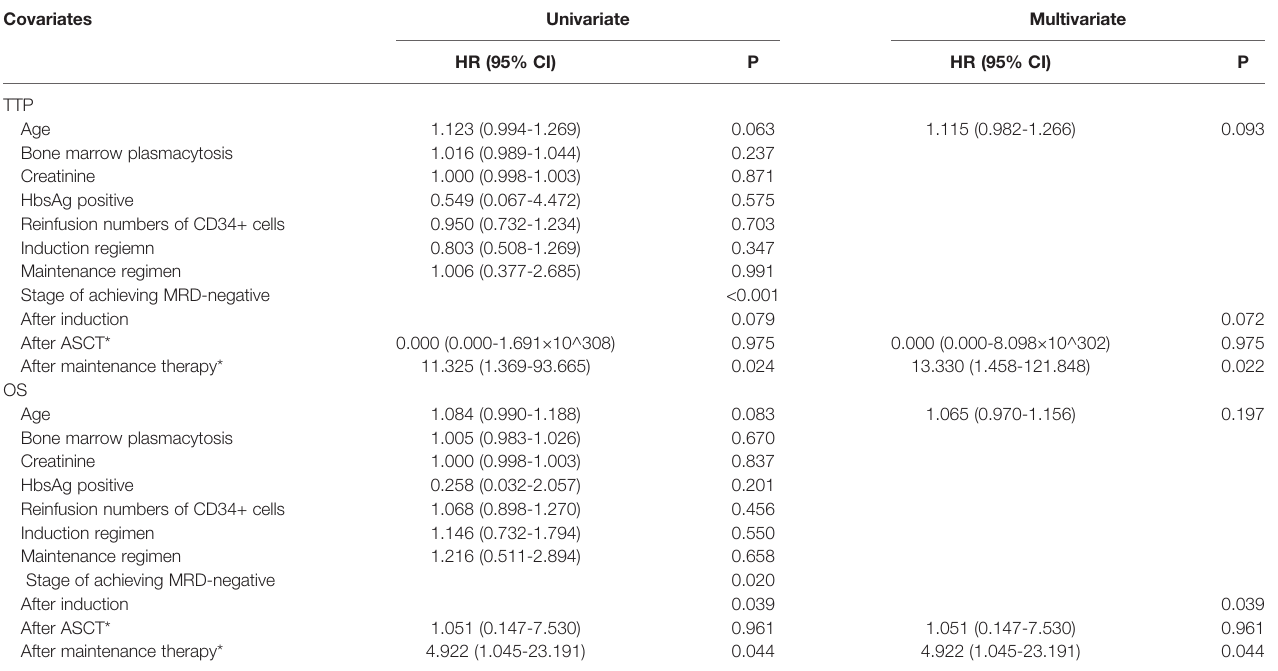
*Compared to patients who achieved MRD-negative after induction